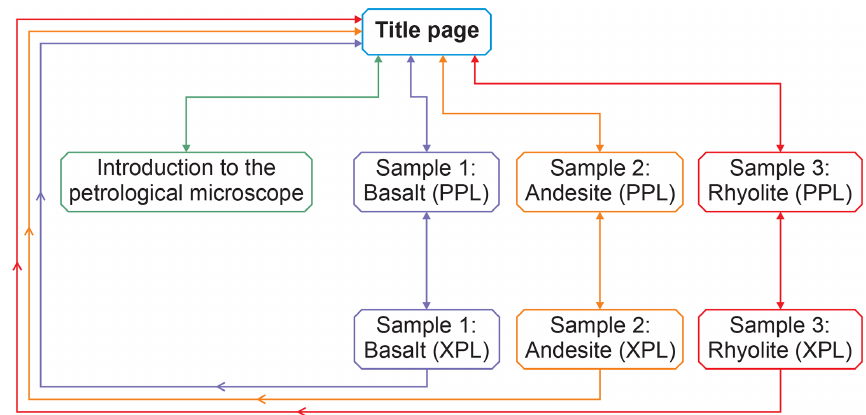
Figure 3. A simplified map highlighting the overall structure of the Thinglink-based learning resource used in this study. Individual interac- tive images are marked with their titles in a coloured box, and clickable links between images, as well as their direction of travel, are marked with coloured arrows. PPL is the plane-polarized light, and XPL is the cross-polarized